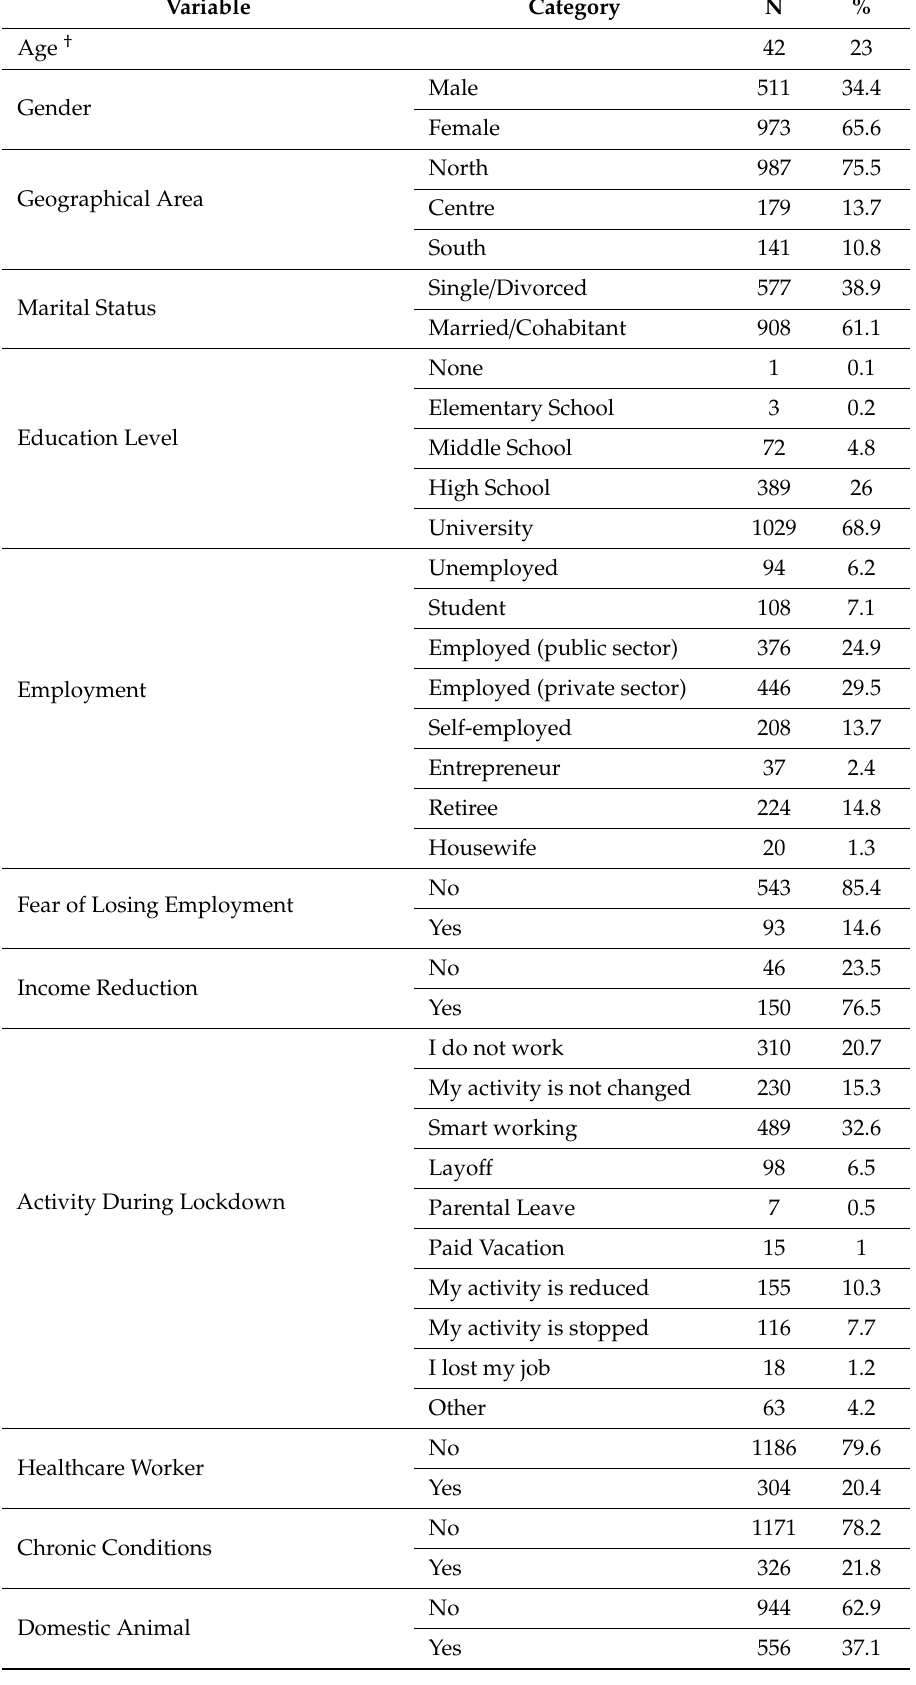
Table 1. Description of the